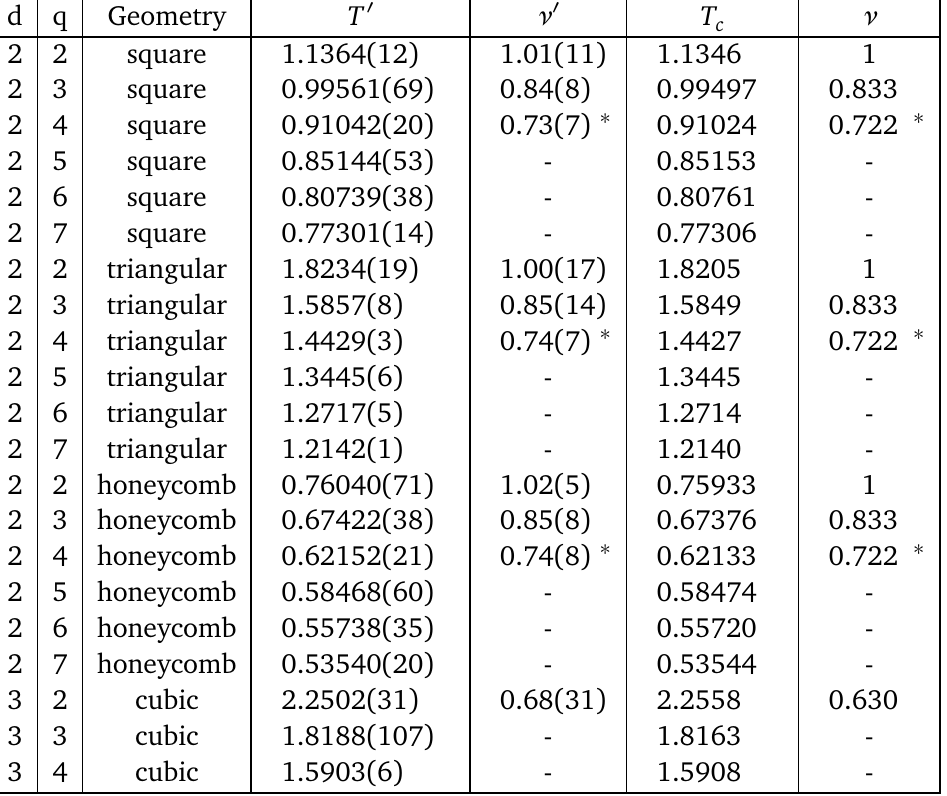
Table 3: Critical properties of the ferromagnetic q -state Potts model obtained using ANNs trained with simplified data. The values of T (cid:48) and ν (cid:48) and their associated standard errors are estimated by finite-size scaling of ANN outputs. Literature values of T and ν are included for comparison. ∗ The values of ν (cid:48) and ν [ 15 ] for the 4-state c Potts model are without higher-order